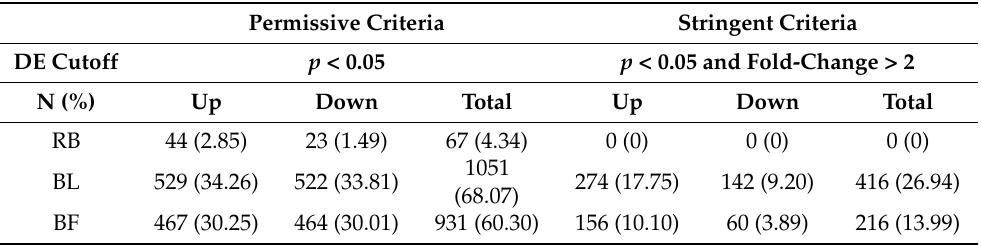
Table 1. The number of differentially expressed genes in B. burgdorferi round body (RB), bleb (BL), and biofilm (BF) dominated cultures compared to